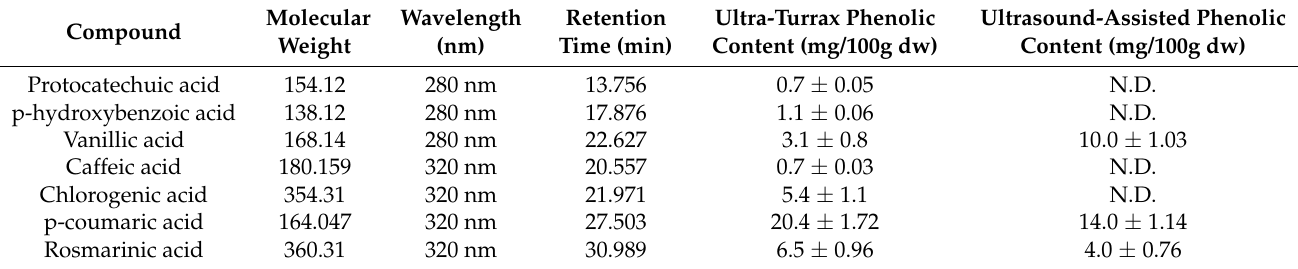
Table 4. Phenolic profile of spent grain obtained in optimal conditions using the HPLC-DAD method.